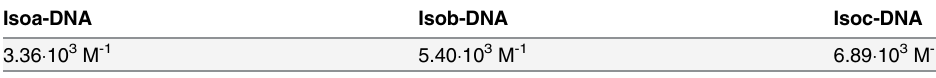
Table 1. Average values of the binding constants for the studied systems.